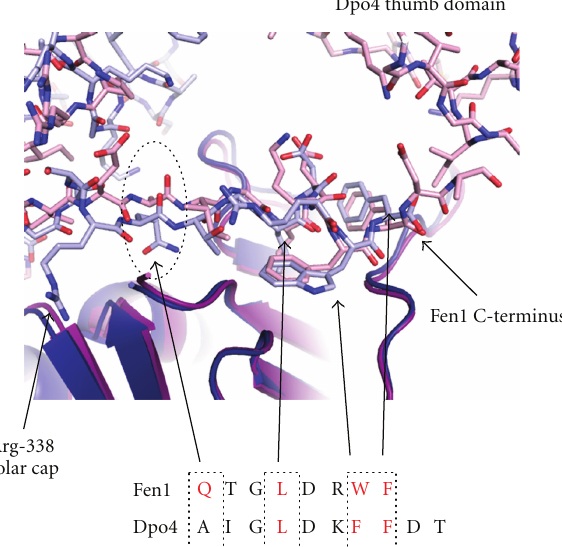
Figure 4: Detailed comparison of the PIP-box interactions of SsoFen1 and Dpo4 with PCNA (see also Figures 2(a) and 2(b)). Fen1 and PCNA1 are shown in light and dark blue, respectively. Dpo4 and its respective PCNA1 are shown in pink and magenta. The position of the conserved glutamine residue is highlighted and the key residues in the interaction motif are indicated in red (2IZO and 3FDS, [9, 10]). Residues in the top right hand corner are part of the Dpo4 thumb domain and are proximal to the extreme C- terminus of the protein.